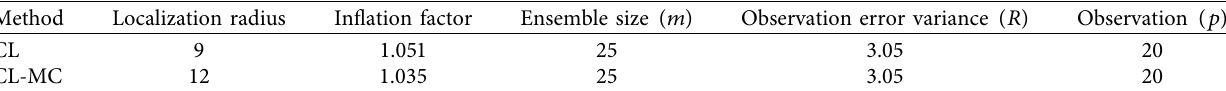
Table 1: Manually tuned optimal localization parameters and default DA parameters for the filters with the Lorenz-96